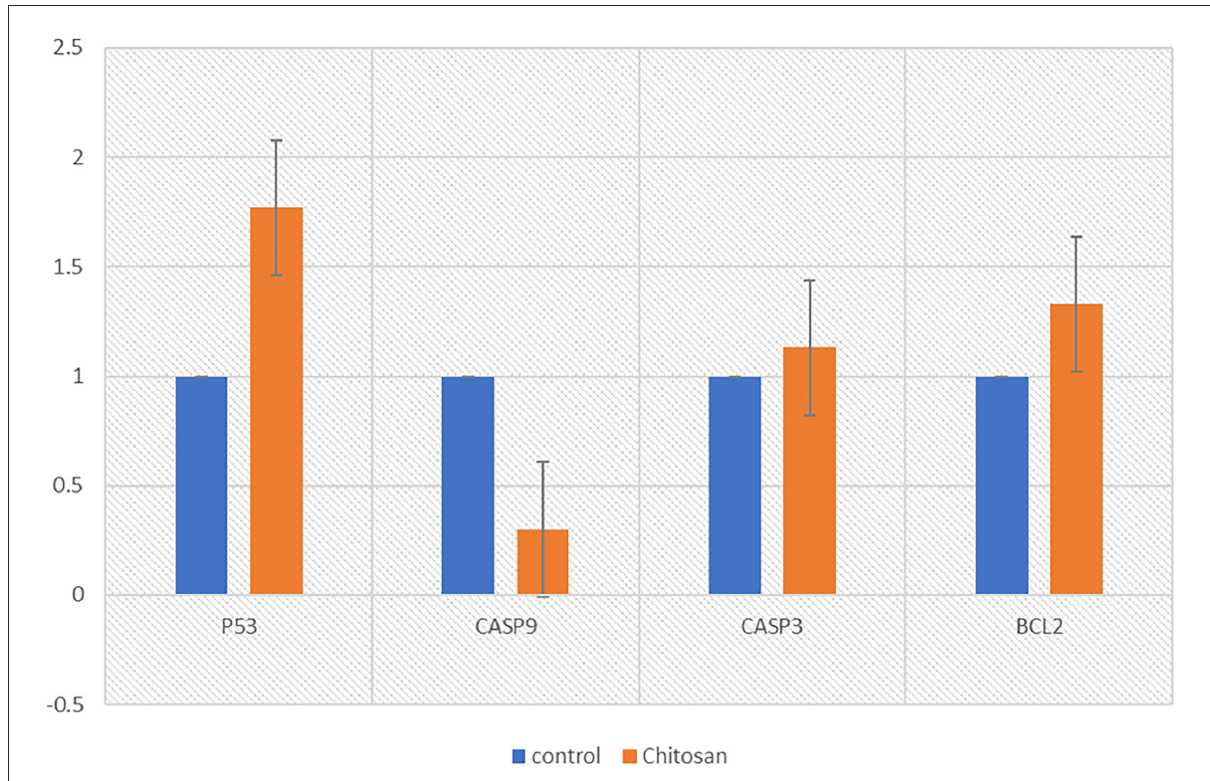
FIGURE8 Chitosan effects on the P53, caspase-3, caspase-9, and BCL_2 mRNA levels in HeLa cells after treatment with chitosan for 24h. The relative quantification of the target gene by the delta-delta-Ct method was done using the Qiagen